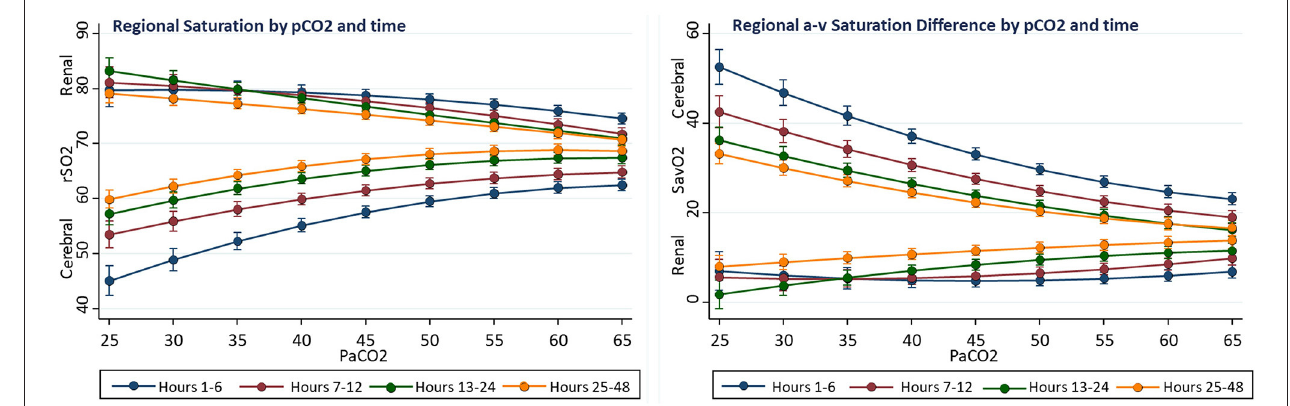
FIGURE 3 | Interactions of time and PaCO2 on regional oxygenation and flow in univariable fixed-effect models. The effect on PaCO2 on cerebral rSO2C decreased with time, while the effect on renal rSO2R